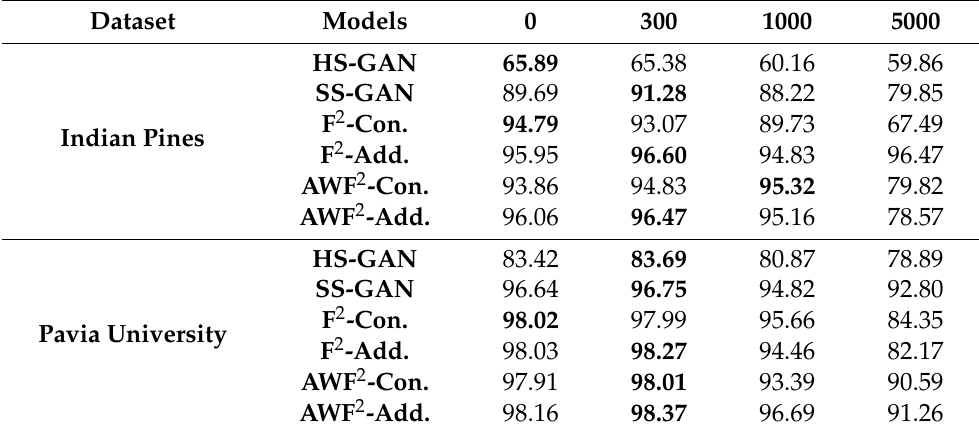
Table 8. The overall accuracies (OA%) of comparison methods using different numbers of unlabeled and 300 labeled HSI samples; experiments conducted on the Indian Pines and Pavia University